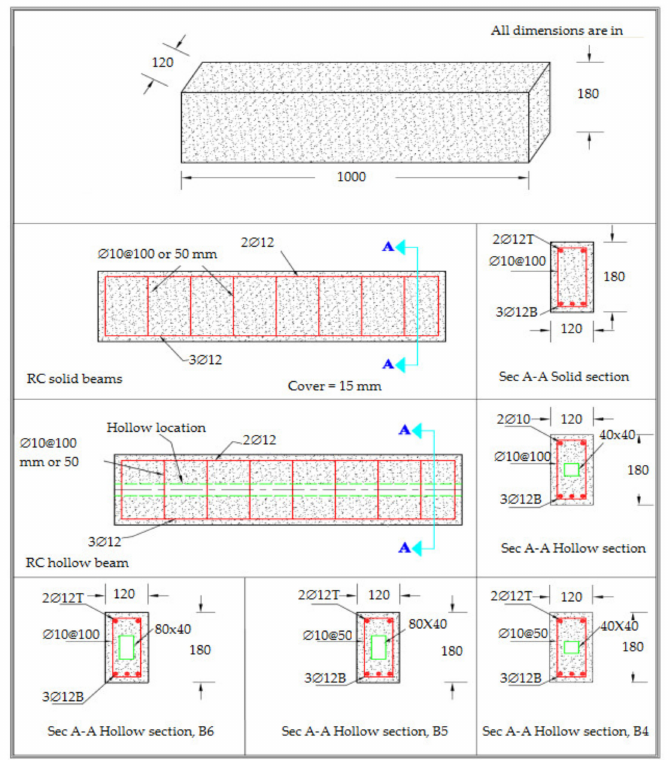
Figure 1. Geometries, layouts, reinforcements, and core details of all RC beam models